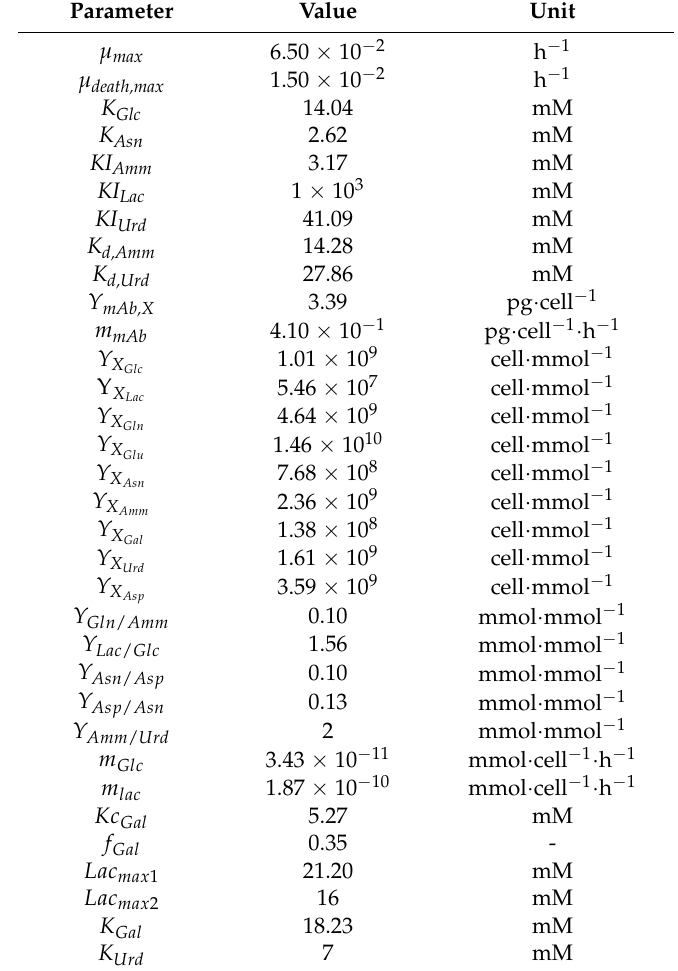
Table 2. Model parameters that were used in the GSA and their nominal values a